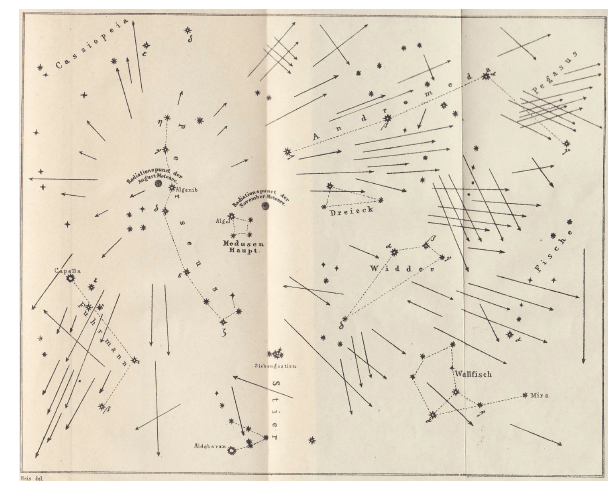
Figure 3. Trails of the Perseids and intersecting showers (Heis, 1855b).